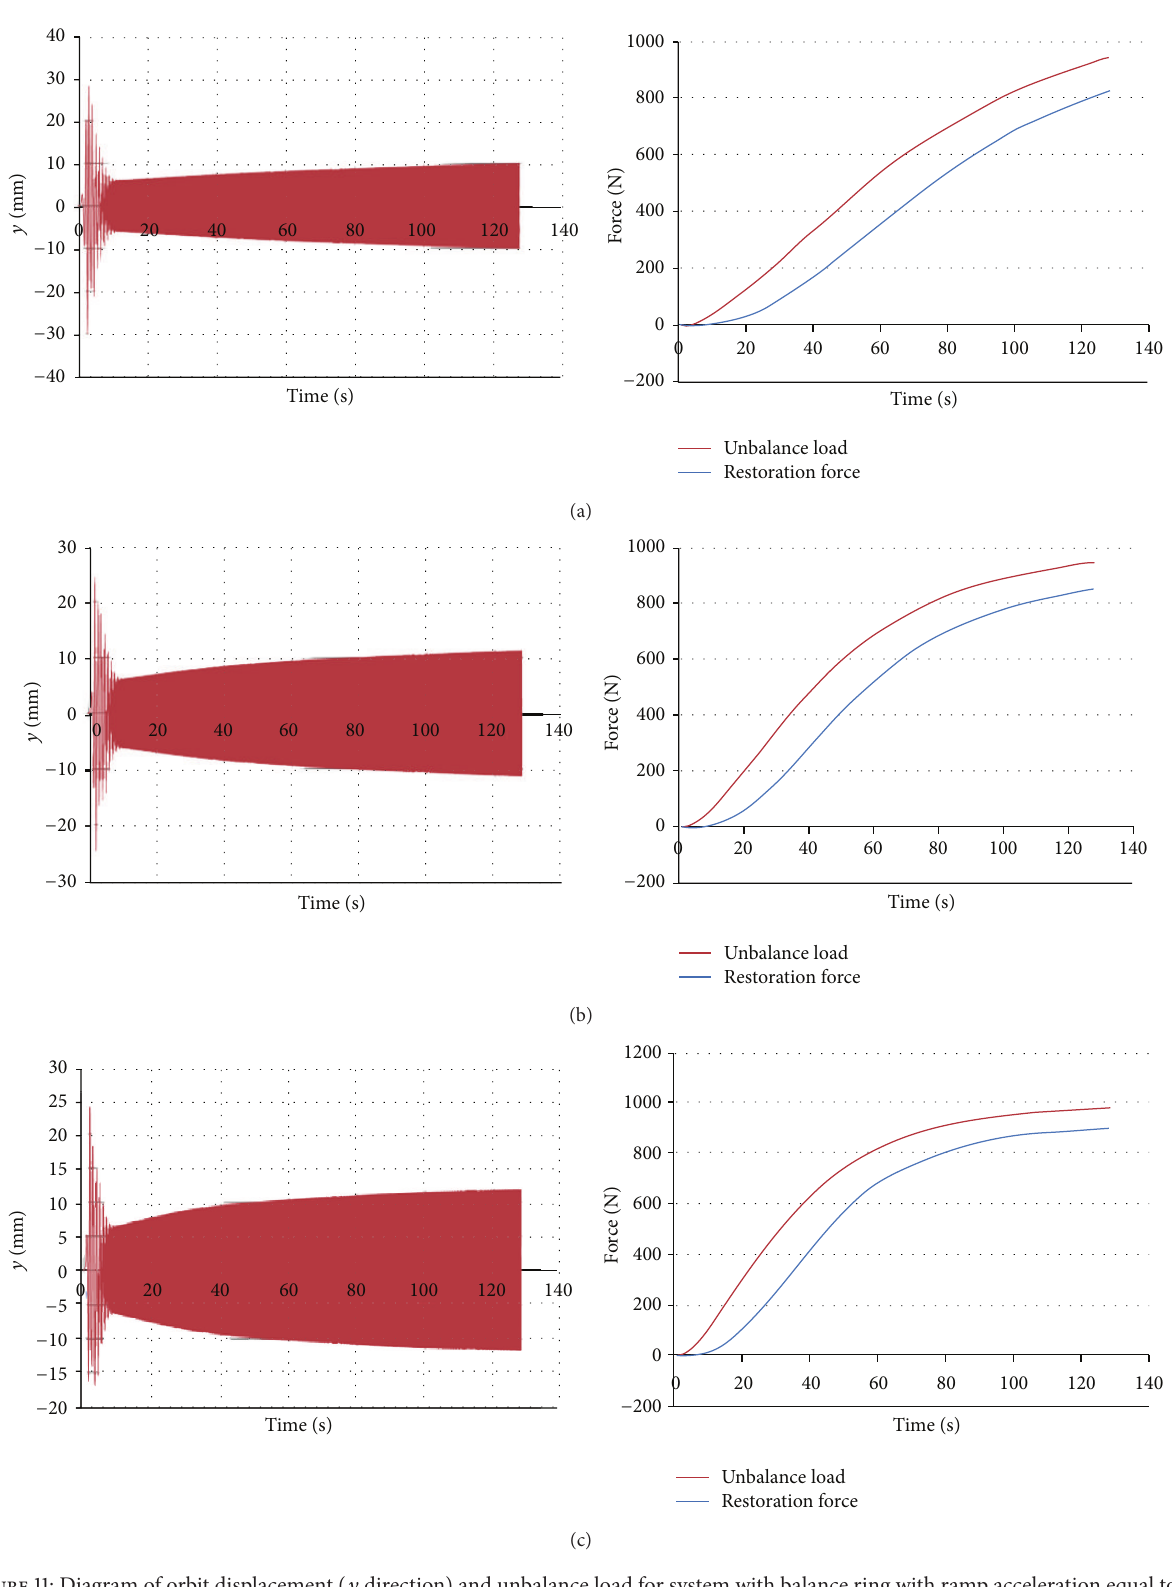
Figure 11: Diagram of orbit displacement ( 𝑦 direction) and unbalance load for system with balance ring with ramp acceleration equal to (a) 15rpm/s; (b) 20 rpm/s; and (c) 25